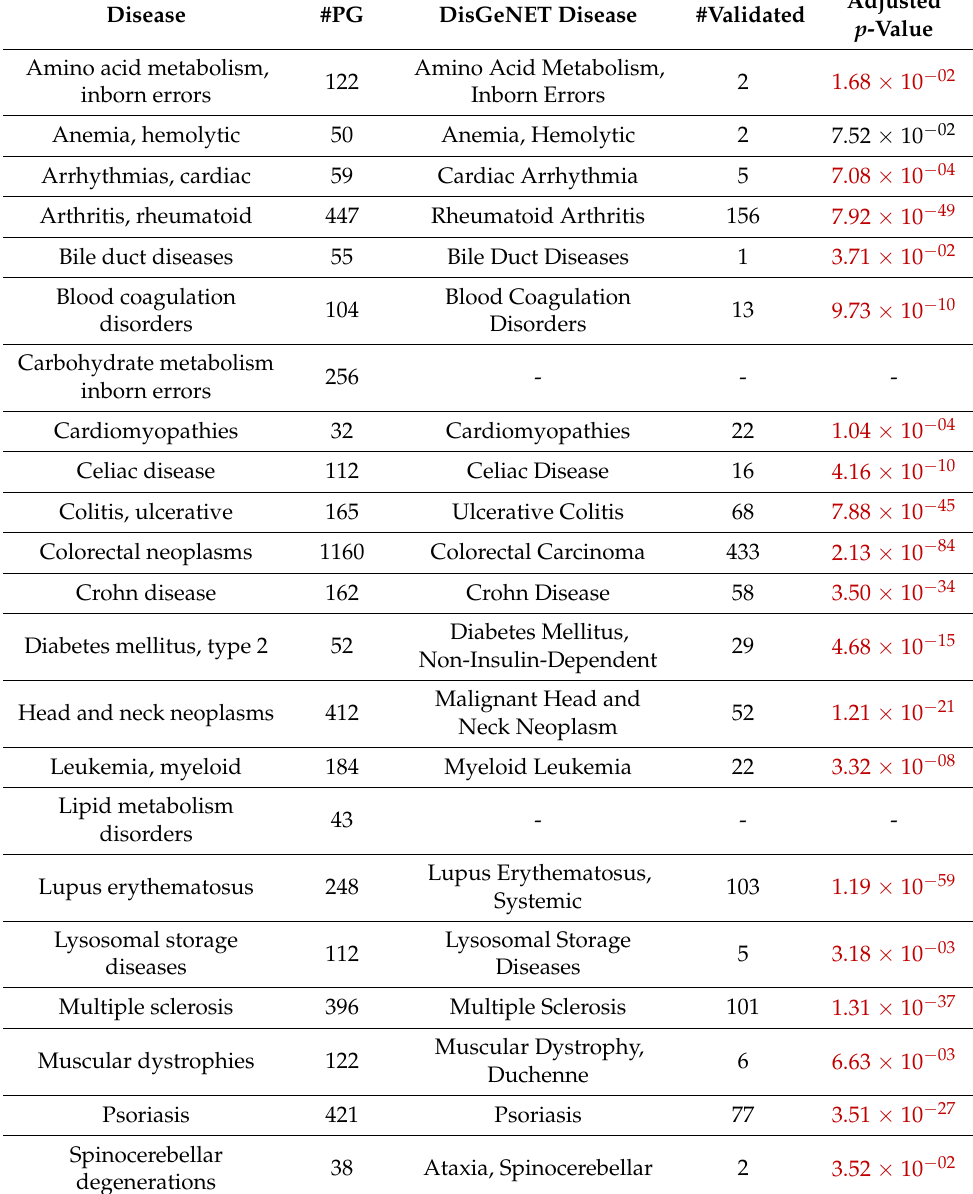
Table 2. Enrichment analysis of putative disease genes performed with Enrichr (Diseases/Drugs category, DisGeNET section). For each disease, we show the number of putative disease genes (PG), the corresponding DisGeNET disease name, the number of validated PG and the adjusted p -value retrieved from Enrichr; p -values below the significance threshold are highlighted in red. Disease #PG DisGeNET Disease #Validated